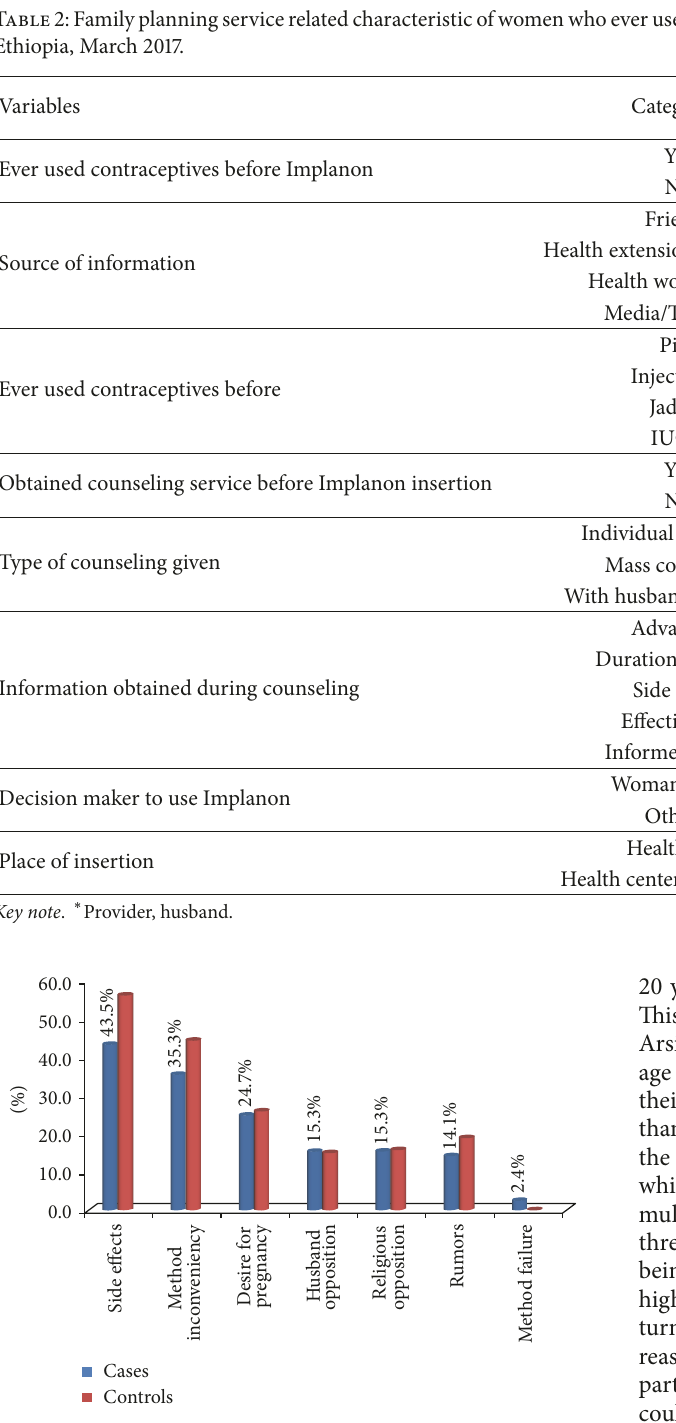
Figure 1: Reason of discontinuation in women who ever used Implanon in Diguna Fango District, Wolayita Zone, Southern Ethiopia, March